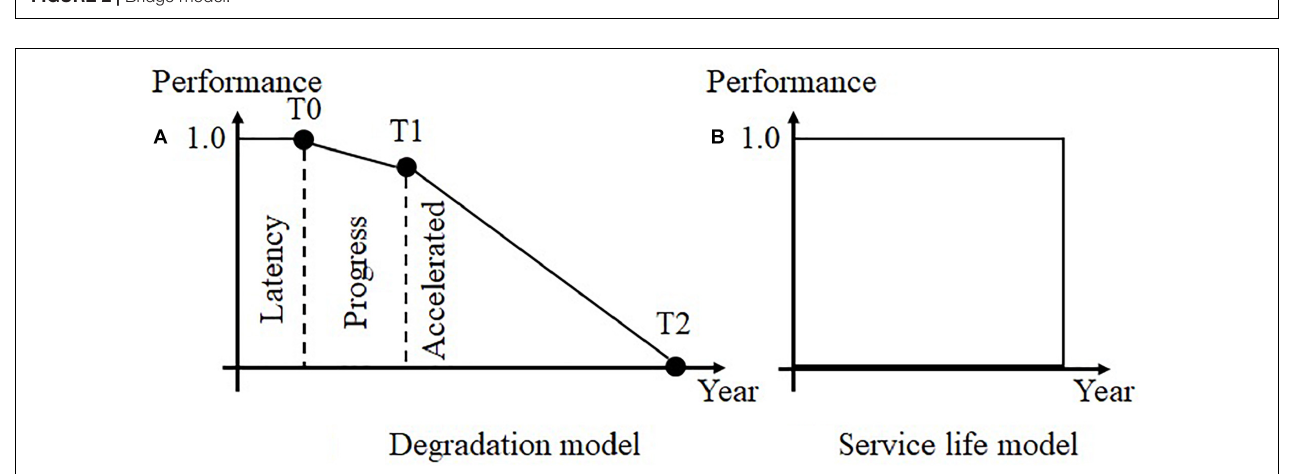
FIGURE 2 | Bridge model.